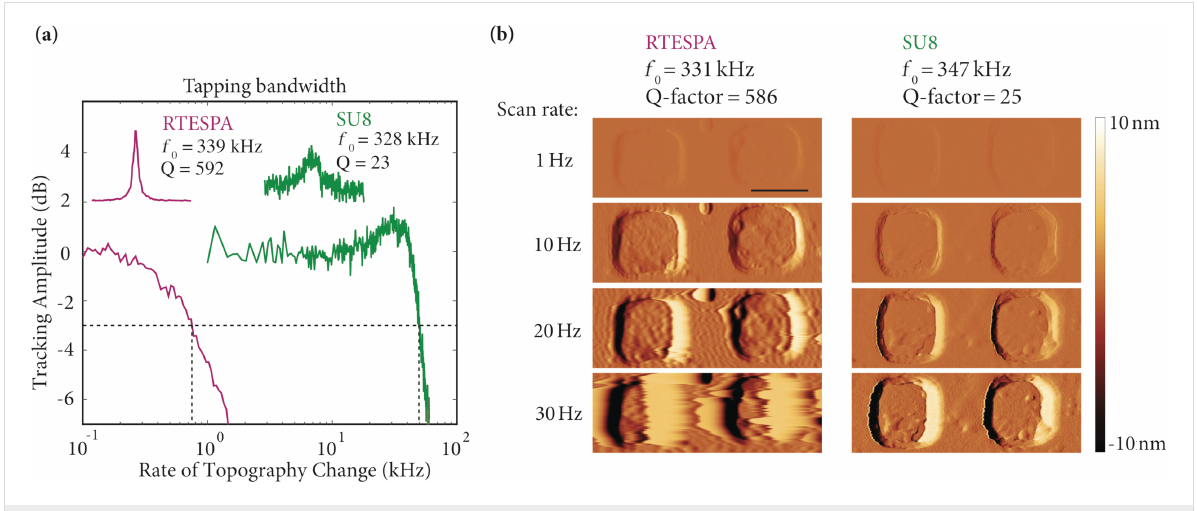
Figure 3: Comparison of the tapping bandwidth between our tip-integrated SU8 cantilever and a commercial silicon cantilever (RTESPA). (a) The 3 dB drop of the surface tracking in tapping mode for RTESPA and the SU8 cantilever happens at 750 Hz and 50 kHz, respectively. RTESPA has f 0 = 339 kHz and Q = 592, and the LSNT-tip SU8 cantilever has f 0 = 328 kHz and Q = 23. (b) Amplitude error images of a 1 µm pitch reference sam- ple taken by the RTESPA silicon cantilever and the LSNT-tip SU8 cantilever at scan rates of 1, 10, 20 and 30 Hz. The SU8 cantilever shows a better topography tracking ability compared to the RTESPA cantilever due to its higher tapping bandwidth. The scale bar is 500 nm.